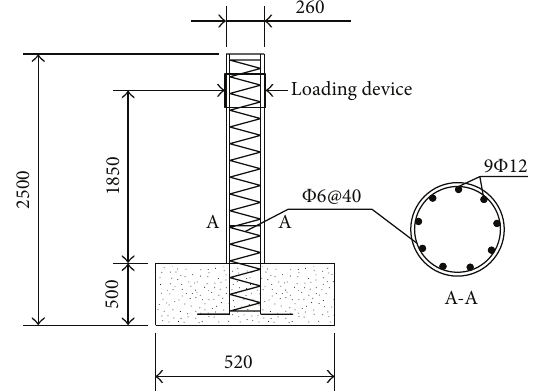
Figure 1: Details of the original specimens (unit: